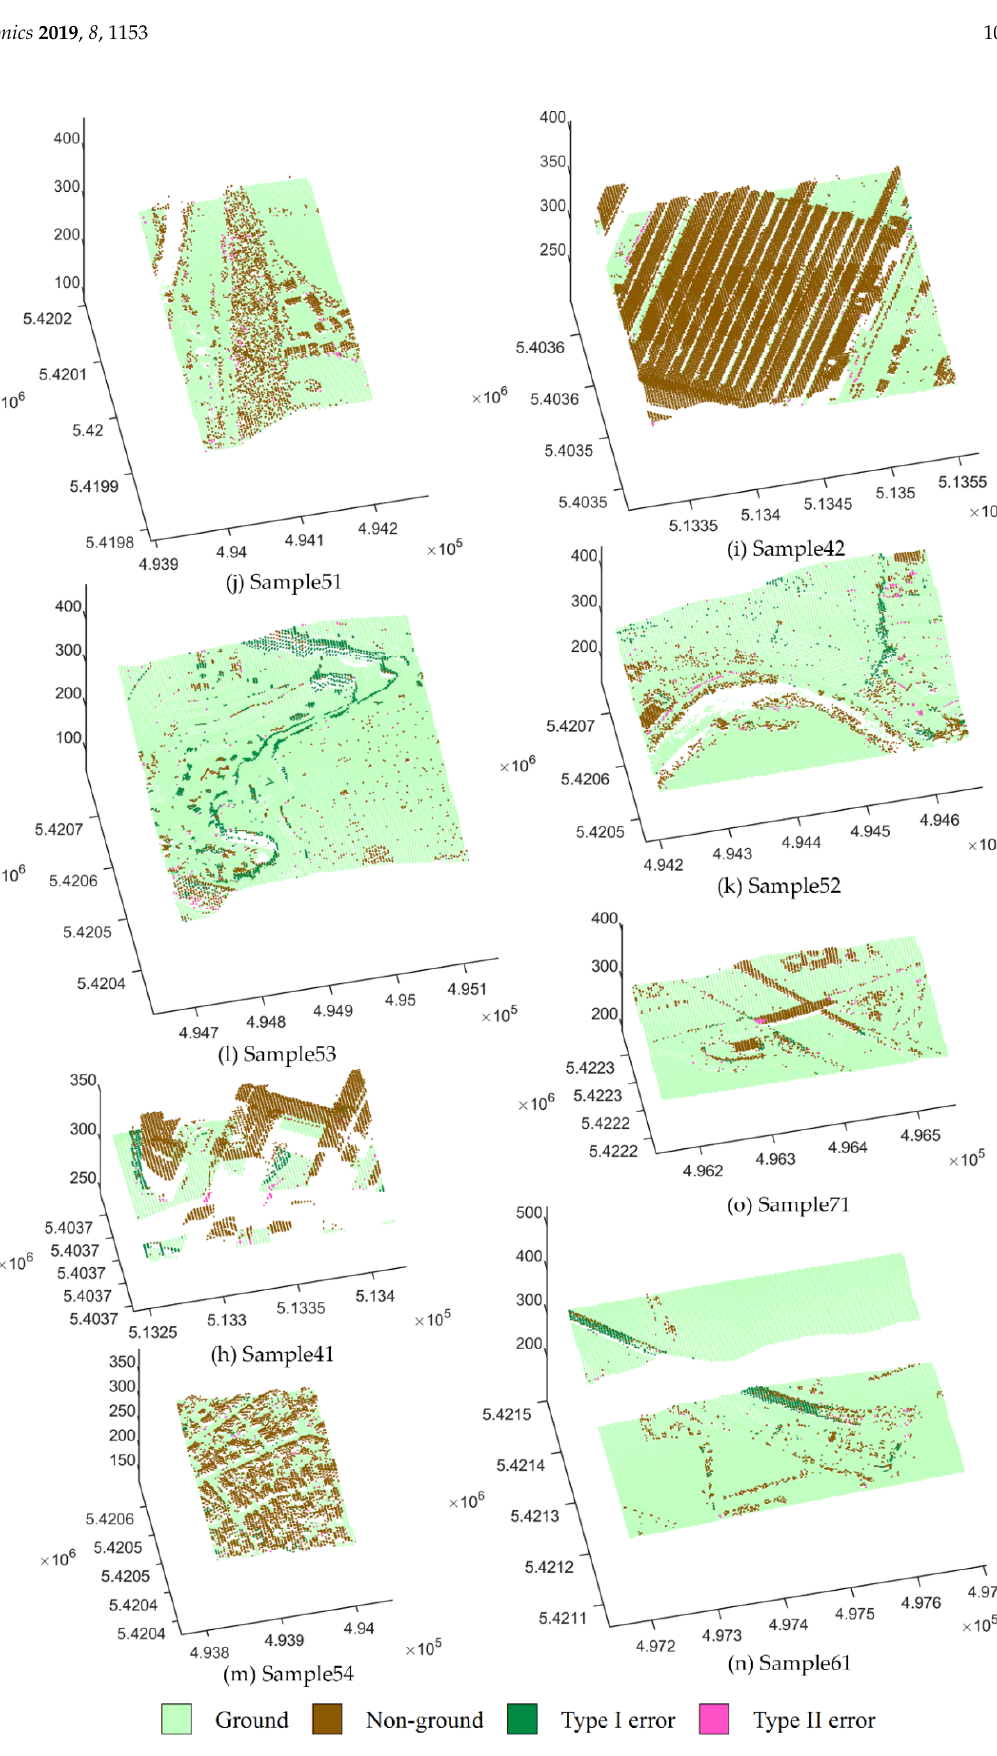
Figure 3. Error distribution of ISPRS samples (continued).